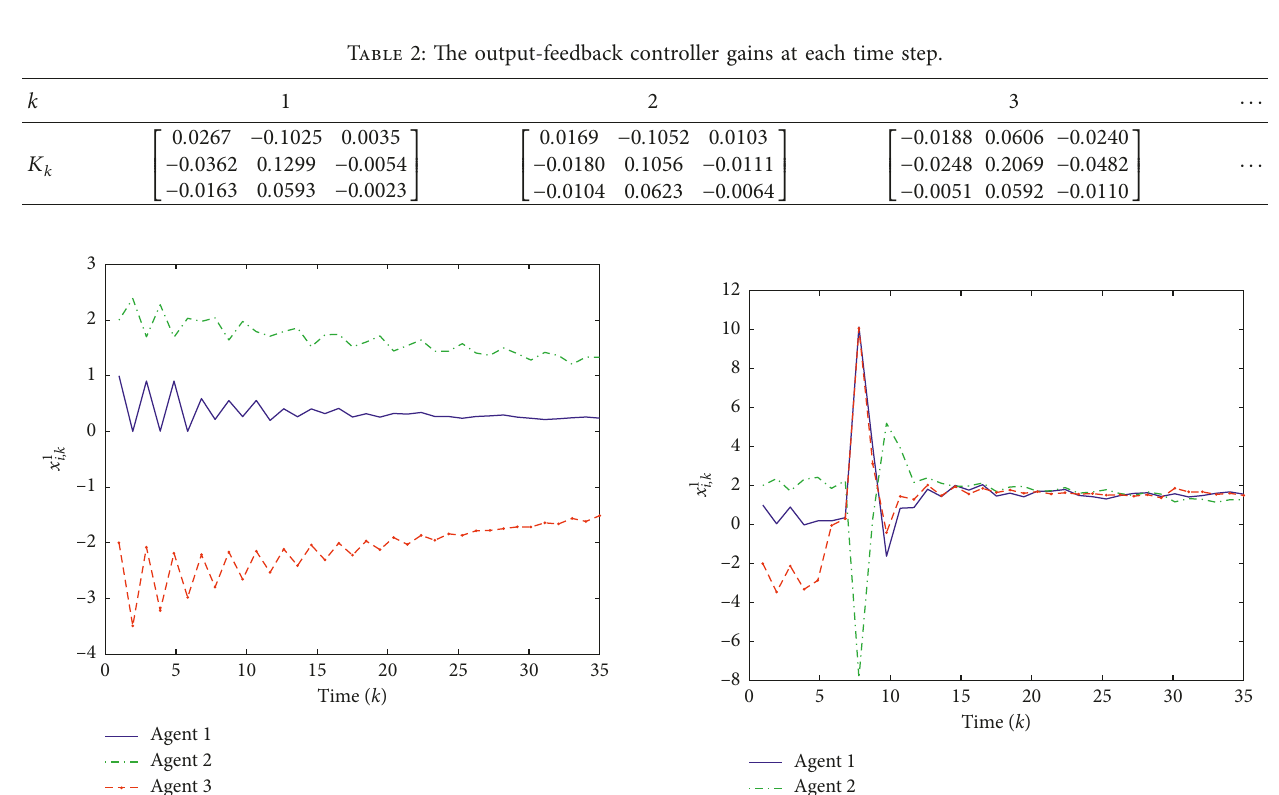
( i � 1 , 2 , 3 ) without the i,k